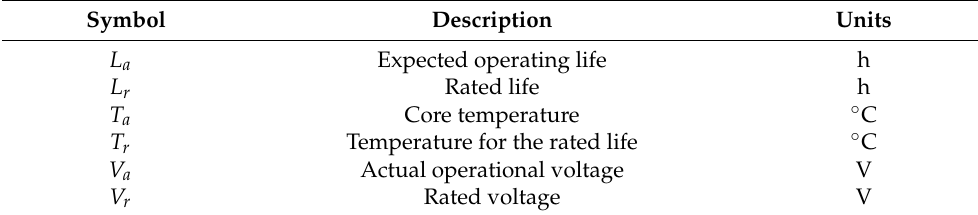
Figure 6. Basic schematic for a super-capacitor (SC). The device has an active material (e.g., car- bon, MnO 2 , LiCoO 2 ), current collectors, a separating membrane and electrolyte, (e.g., Na 2 SO 4 , or LiPF 6 solutions). Table 7. Nomenclature for